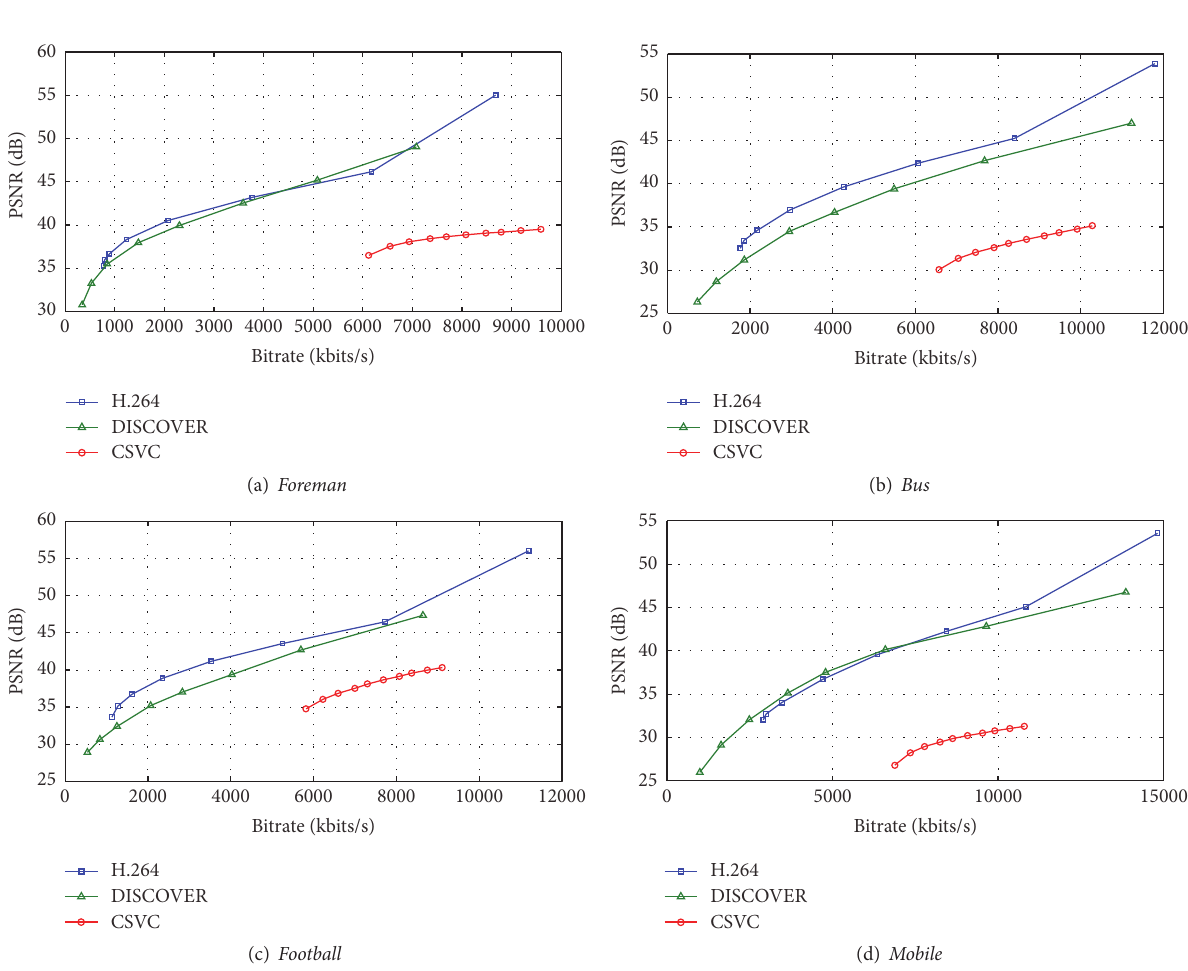
more gentle, which shows that H.264 has a high dependency on energy consumption with its promotion of performance, and DISCOVER also needs a certain amount of energy